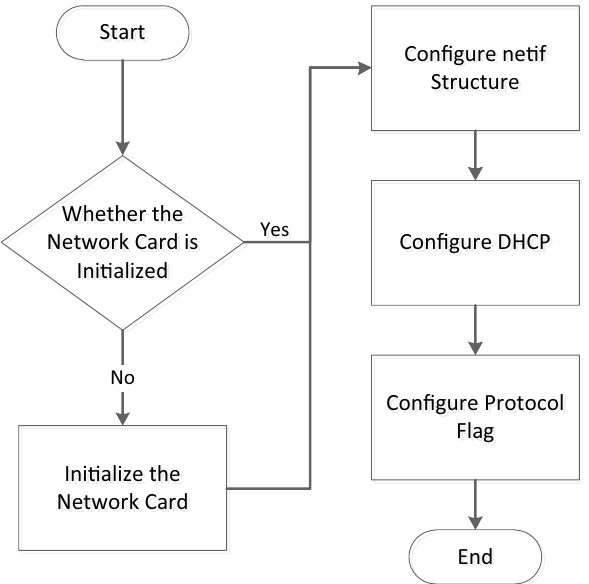
Figure 7. Network driver layer initialization and configuration